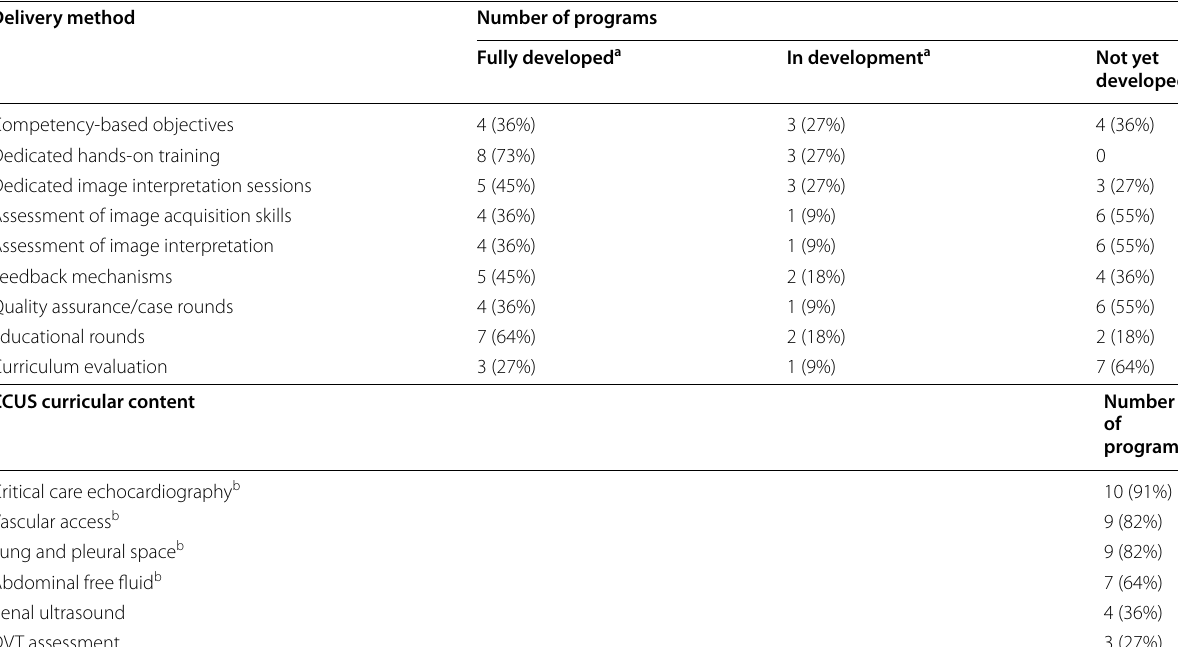
Table 1 Development of current curricular delivery mechanisms and CCUS